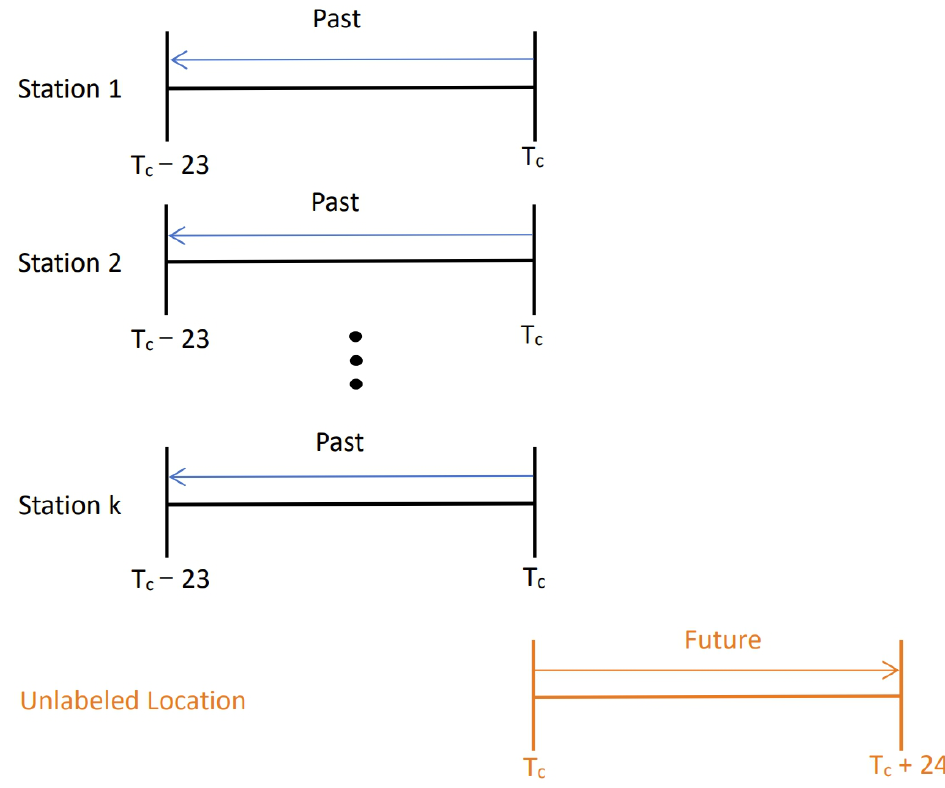
Figure 4. The method to collect available data in time